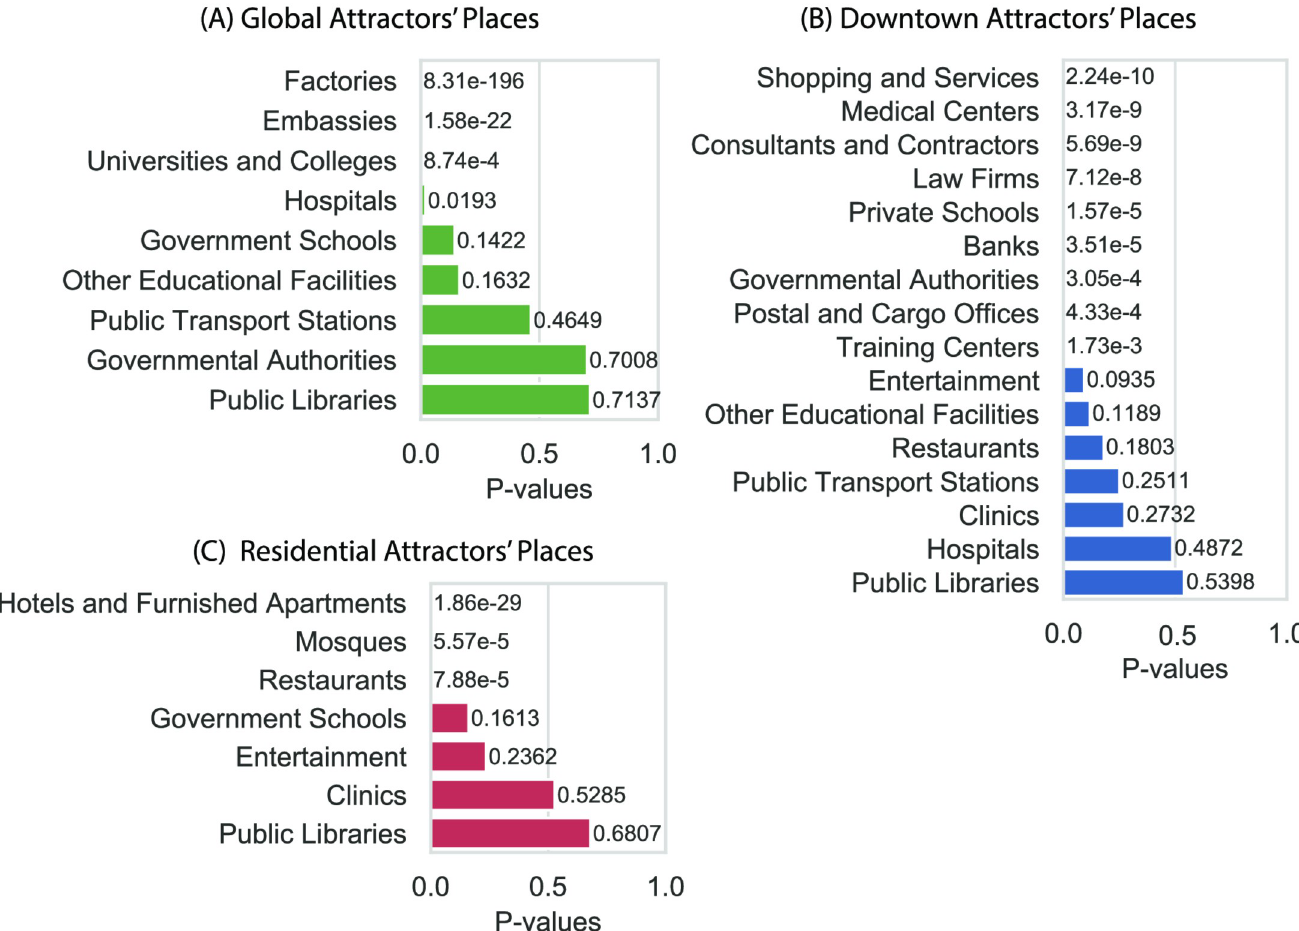
Fig 7. The types of POIs ordered by their statistical significance in the corresponding attractor’s type. (A) The p-values of finding each of the POI types in TAZes classified as global attractors, showing that factories, embassies, universities, and hospitals are type of services significantly located in global attractors. (B) POI types that are significant for the downtown attractors, which mostly includes business types and services. (C) POI types significantly present in the residential attractors that includes services and amenities such as furnished apartments, mosques (places of worship for Muslims), and public